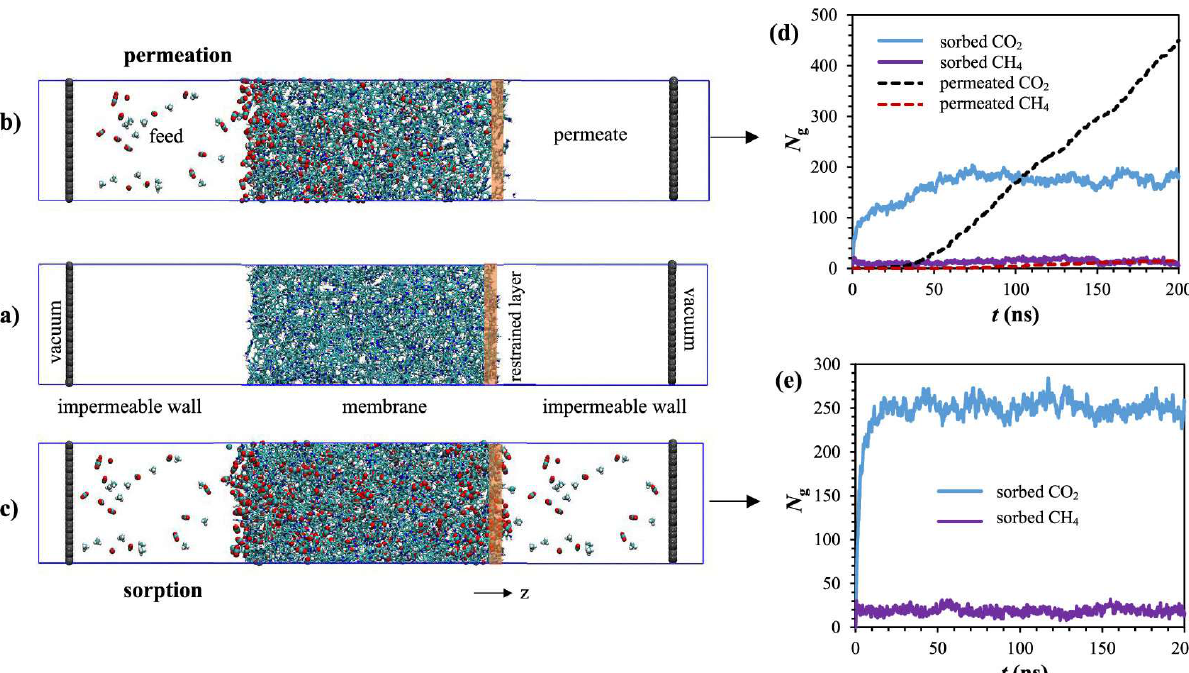
Figure 24. Simulation of CO 2 /CH 4 mixture permeation through a thin membrane layer. ( a ) Membrane with a thin layer position-restrained along the z -axis; ( b ) system for permeation of the CO 2 /CH 4 mixture; ( c ) system for sorption of the CO 2 /CH 4 mixture; ( d ) number of sorbed and permeated gas molecules during permeation; ( e ) number of sorbed gas molecules during sorption. Reproduced with permission from Ref. [399]. Copyright 2019, American Chemical Society.